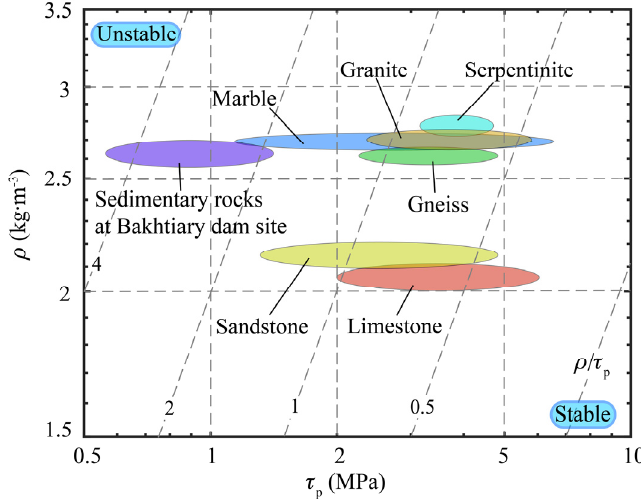
Figure 6. Stability of rock joints in landslides.